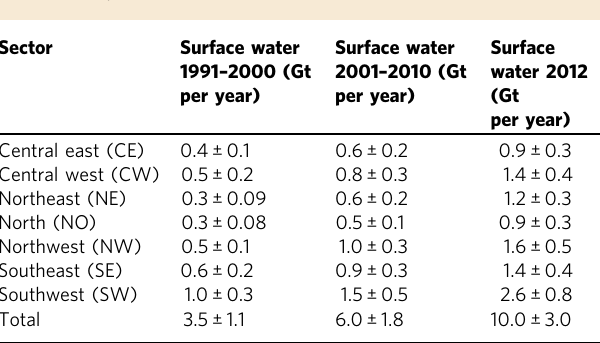
Fig. 3 Basal melt discharge due to friction heat from winter 2000/2001 through to summer 2019. Blue and turquoise colours indicate results based on the gap- fi lled MEaSUREs dataset (see methods). Orange colours indicate that results are from the PROMICE Sentinel-1 derived velocities. Black line is best linear fi t through the MEaSUREs datasets (from the years 2005/2006, 2007/2008, 2008/2009, 2009/2010, 2012/2013, 2014/2015, 2015/2016 and 2016/2017), dashed black lines represent best linear fi t if internal ice deformation temperatures are offset by ±5 °C. The shape of the points indicate origin of surface and bed topographies. Table 2 Basal melting in Gt per year due to surface melt- water heat for decadal averages 1991 – 2000